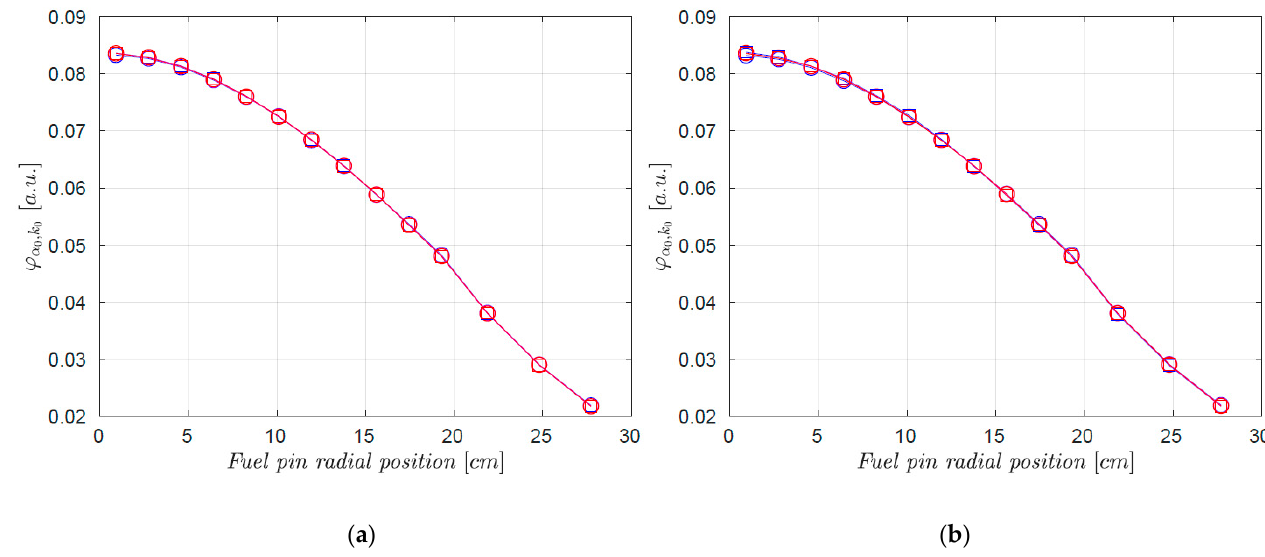
Figure 11. Direct fundamental eigenmodes of the CROCUS reactor as a function of the fuel pin positions, H1 ( a ) and H2 ( b ) configurations according to the α - (blue) and k - (red) eigenvalue formulations, with (squares) and without (circles) precursor contributions.